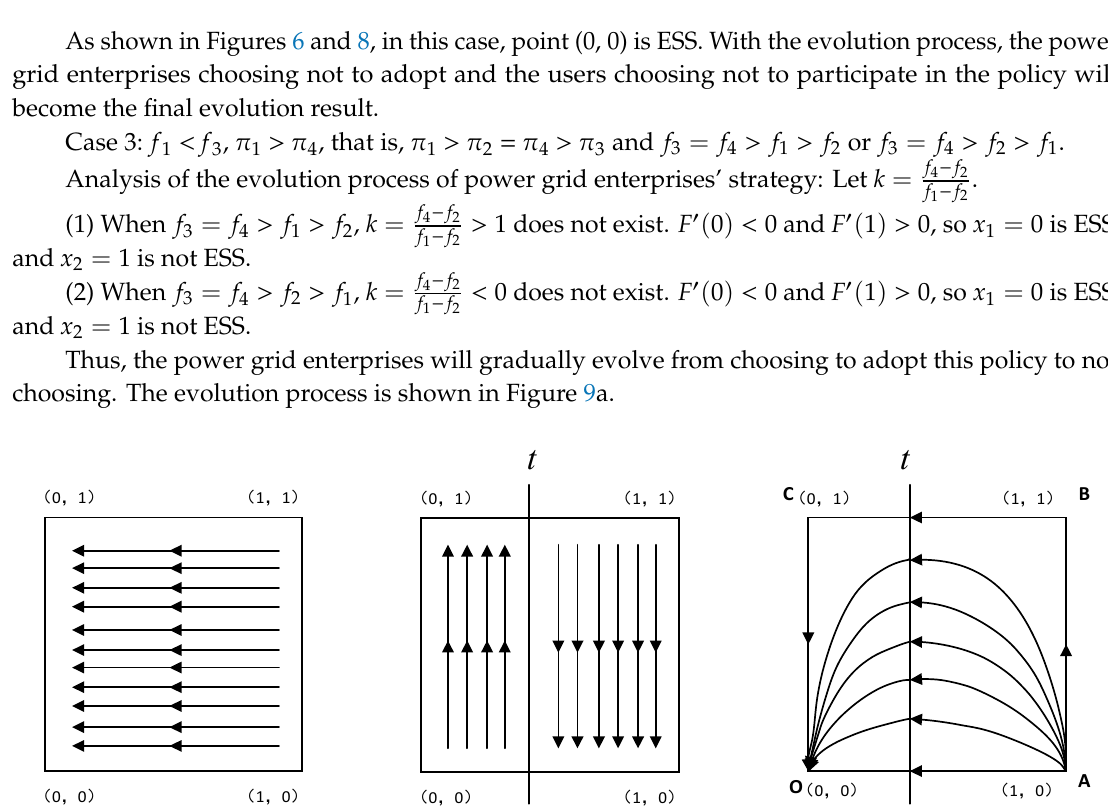
Figure 8. Evolution of the integrated strategy in Case 2.